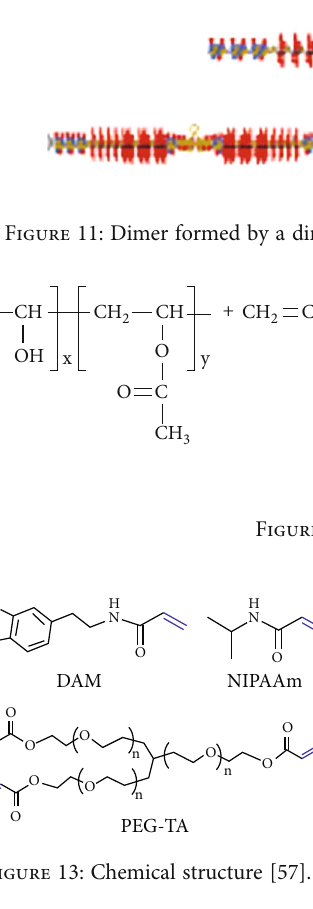
Figure 10: Schematic diagram of crosslinked coating microstructure constructed by microspheres [55].